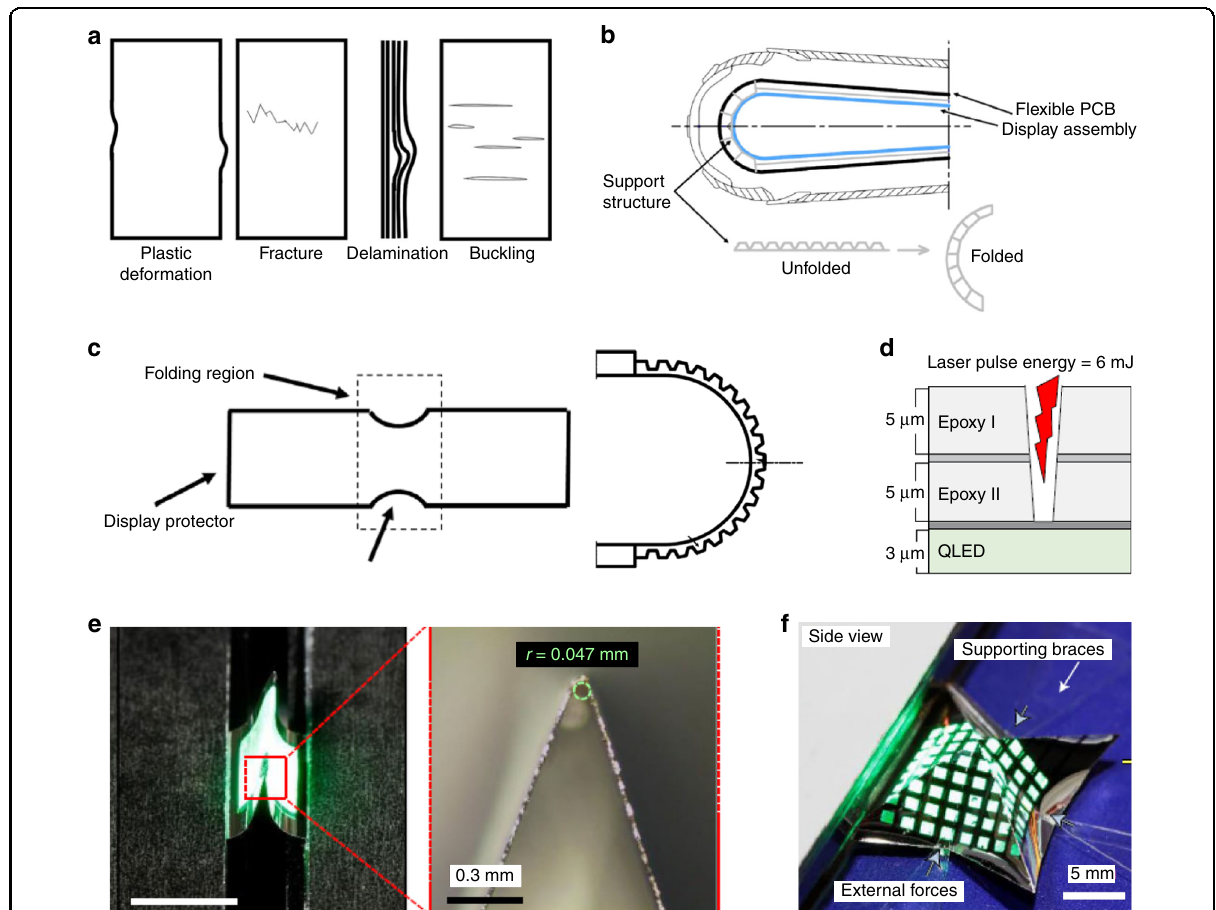
Fig. 5 Stress minimization in the 2D expandable displays. a Mechanical failure that can occur during repeated folding cycles. Reproduced with permission 37 Copyright 2021 ASME. b , c Patterned supporting structure ( b ) and protecting cover layer ( c ) to absorb stress in the folded region. Reproduced with permission 37 Copyright 2021 ASME. d Partial laser etching in the folded region of the top panel layer to realize multi-axis foldable displays. Reproduced with permission 44 Copyright 2021 Springer Nature. e , f Folding/bending characteristic of a patterned QLED ( e ) and 3D multi- axis folding of QLED ( f ). Reproduced with permission 44 Copyright 2021 Springer